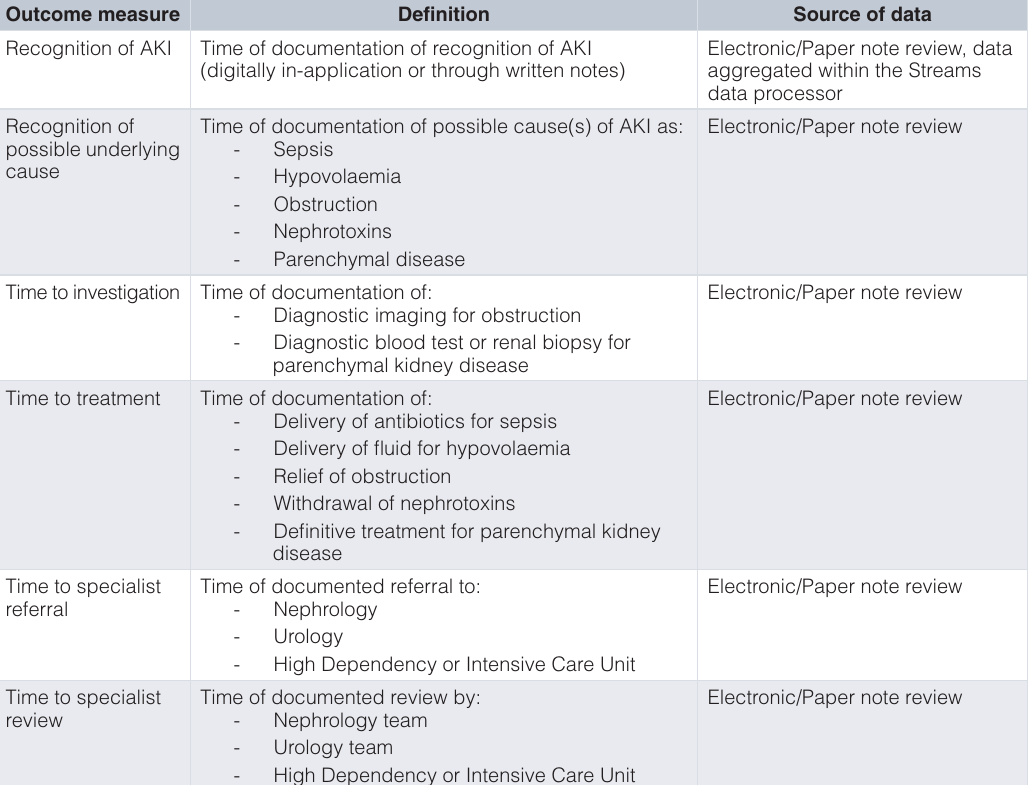
Table 1. Definitions and data sources for all process of care outcome measures.